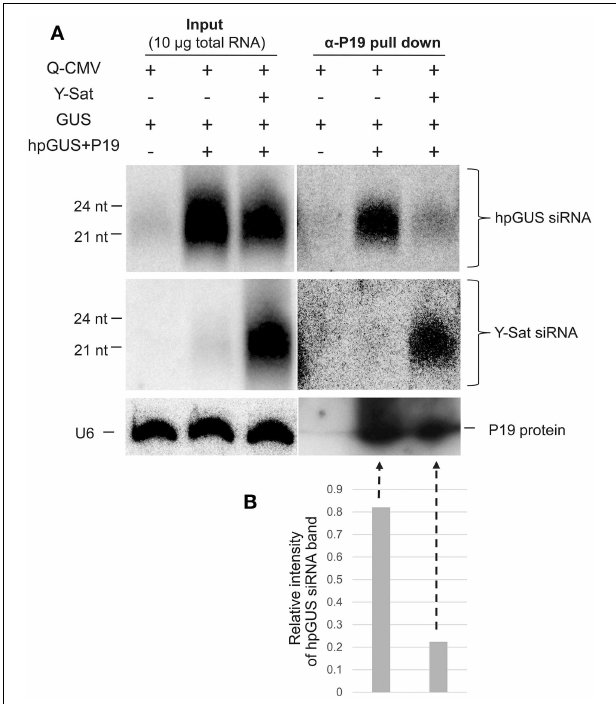
FIGURE 5 | RNA immunoprecipitation assay shows reduced binding of hpGUS -derived siRNAs to P19 in the presence of Y-Sat. (A) The amounts of GUS and Y-Sat siRNAs from the input (left three lanes) and RNA-IP (right three lanes) were determined by northern blot hybridization, which showed a strong reduction of hpGUS-derived siRNAs (top right panel) and abundant Y-Sat-derived siRNAs (middle right panel) in the presence of Y-Sat. The amounts of P19 protein in the RNA-IP pull-down product are indicated by Western blot (bottom right panel). The sizes of hpGUS- and Y-Sat-derived siRNAs are indicated. U6 small nuclear RNA hybridized by the U6 probe described above was used as a loading control for the input samples (bottom left panel). (B) Relative intensity of the α -P19 pull-down hpGUS siRNA band (the last two lanes of the top panel) after normalization against the P19 protein band (the last two lanes of the bottom